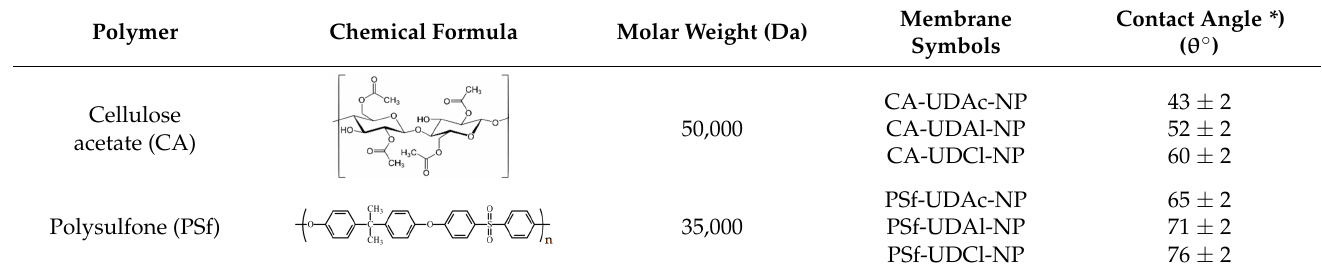
Table 2. The characteristics of polymers for the obtained membranes.